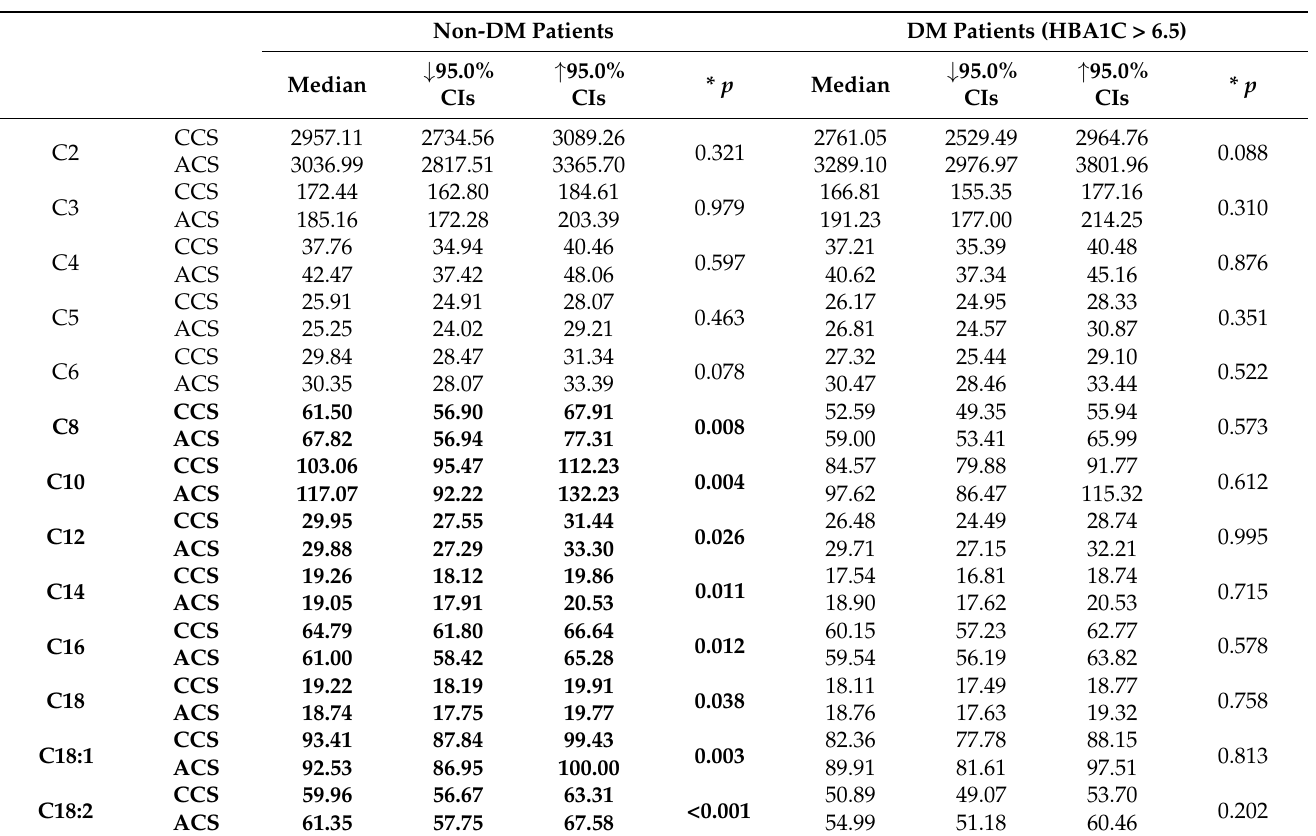
Table 4. DM vs non-DM acylcarnitines levels ( µ g/L) in ACS and CCS patients. Statistically significant values are shown in